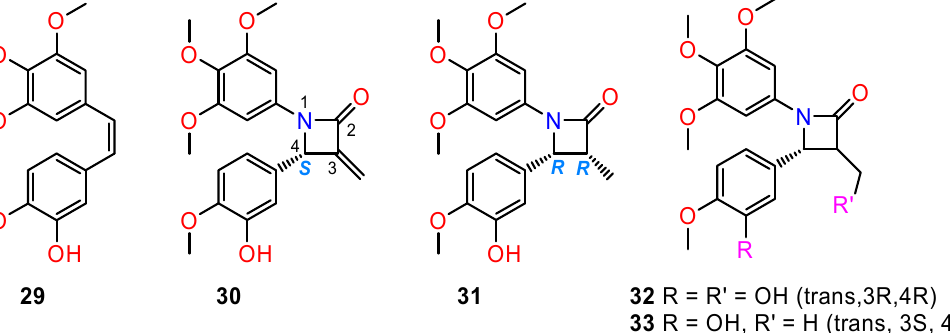
Figure 13. The structures of combrestatin ( 30 ) and its selected derivatives with strong tubulin-inhibitory activity ( 31 – 34 ).